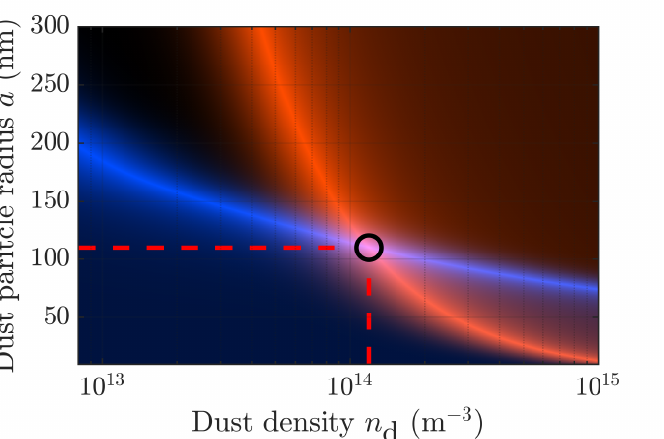
Figure 4. Visualization of the optimization procedure for a specific moment in time. The red region indicates pairs of a and n d with a high goodness of fit with respect to the MCRS measurements (i.e., low relative MCRS error χ mcrs ), whereas the blue region indicates a high goodness of fit with respect to the extinction measurements (i.e., low relative extinction error χ ext ). Since the measurements are obtained in a time-synchronized way, the intersection of two regions (indicated in magenta) indicates the most likely ( a , n d ) pair, here indicated by the black circle. In this case, the determined dust particle size and dust density are a = 110nm and n d = 1.19 × 10 14 m − 3 ,